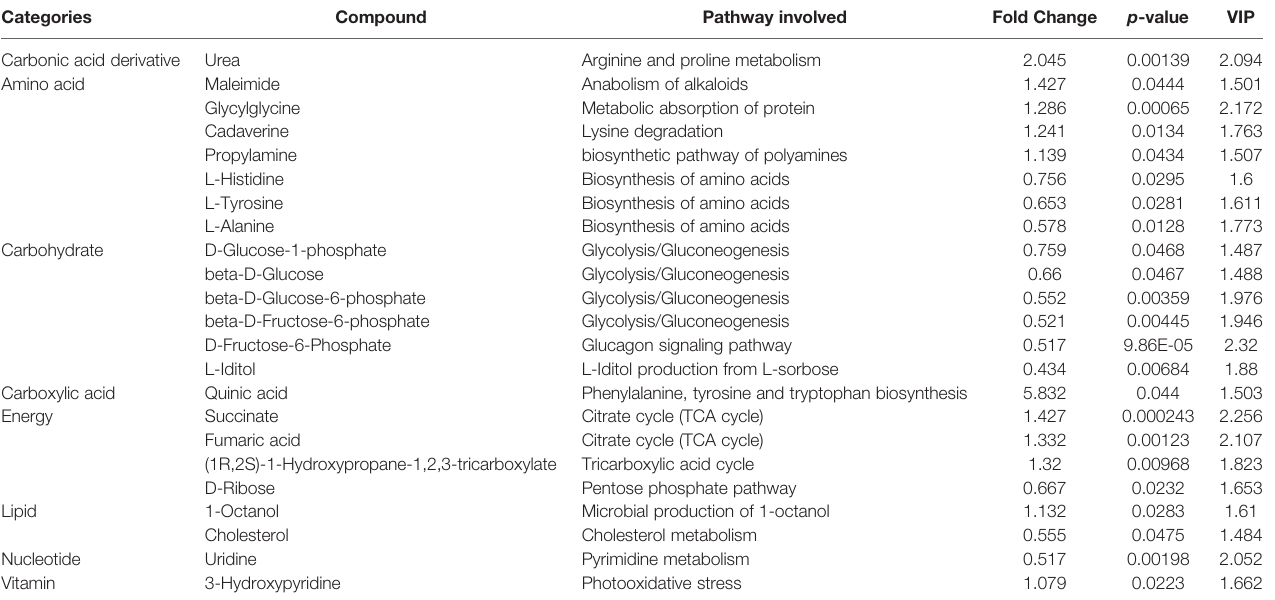
TABLE 3 | Signi fi cantly changed differential metabolites in EW vs. EU groups.